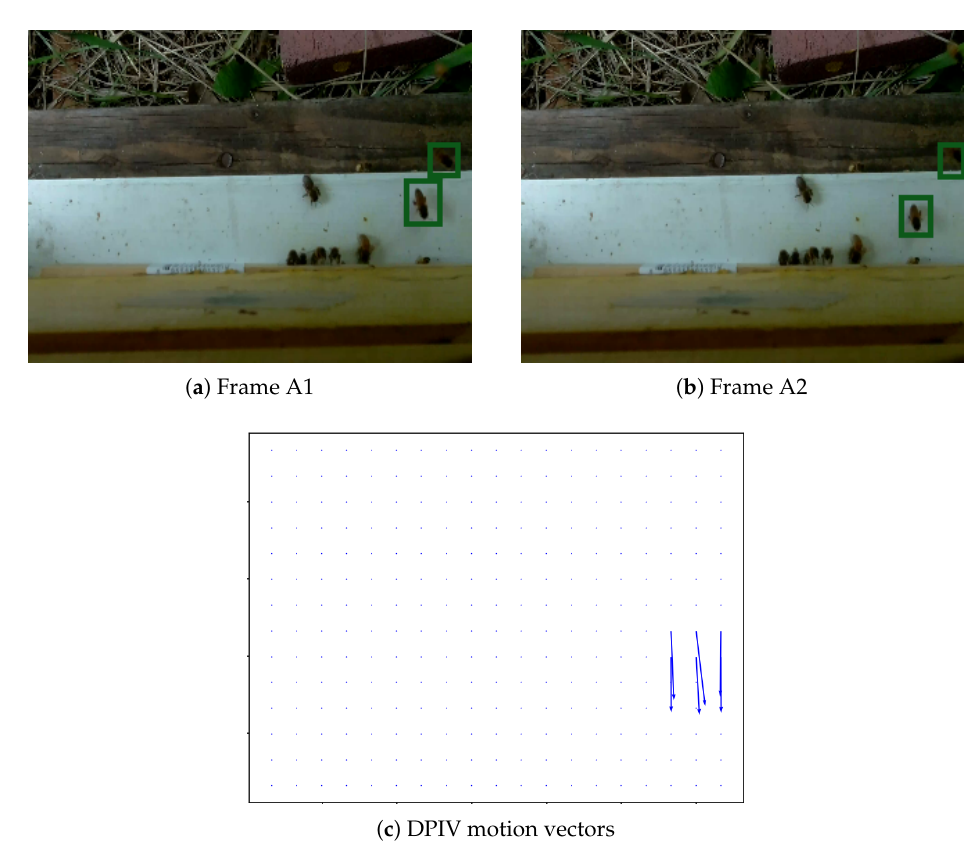
Figure A1. Two consecutive video frames A1 and A2, with two bees moving and corresponding DPIV motion